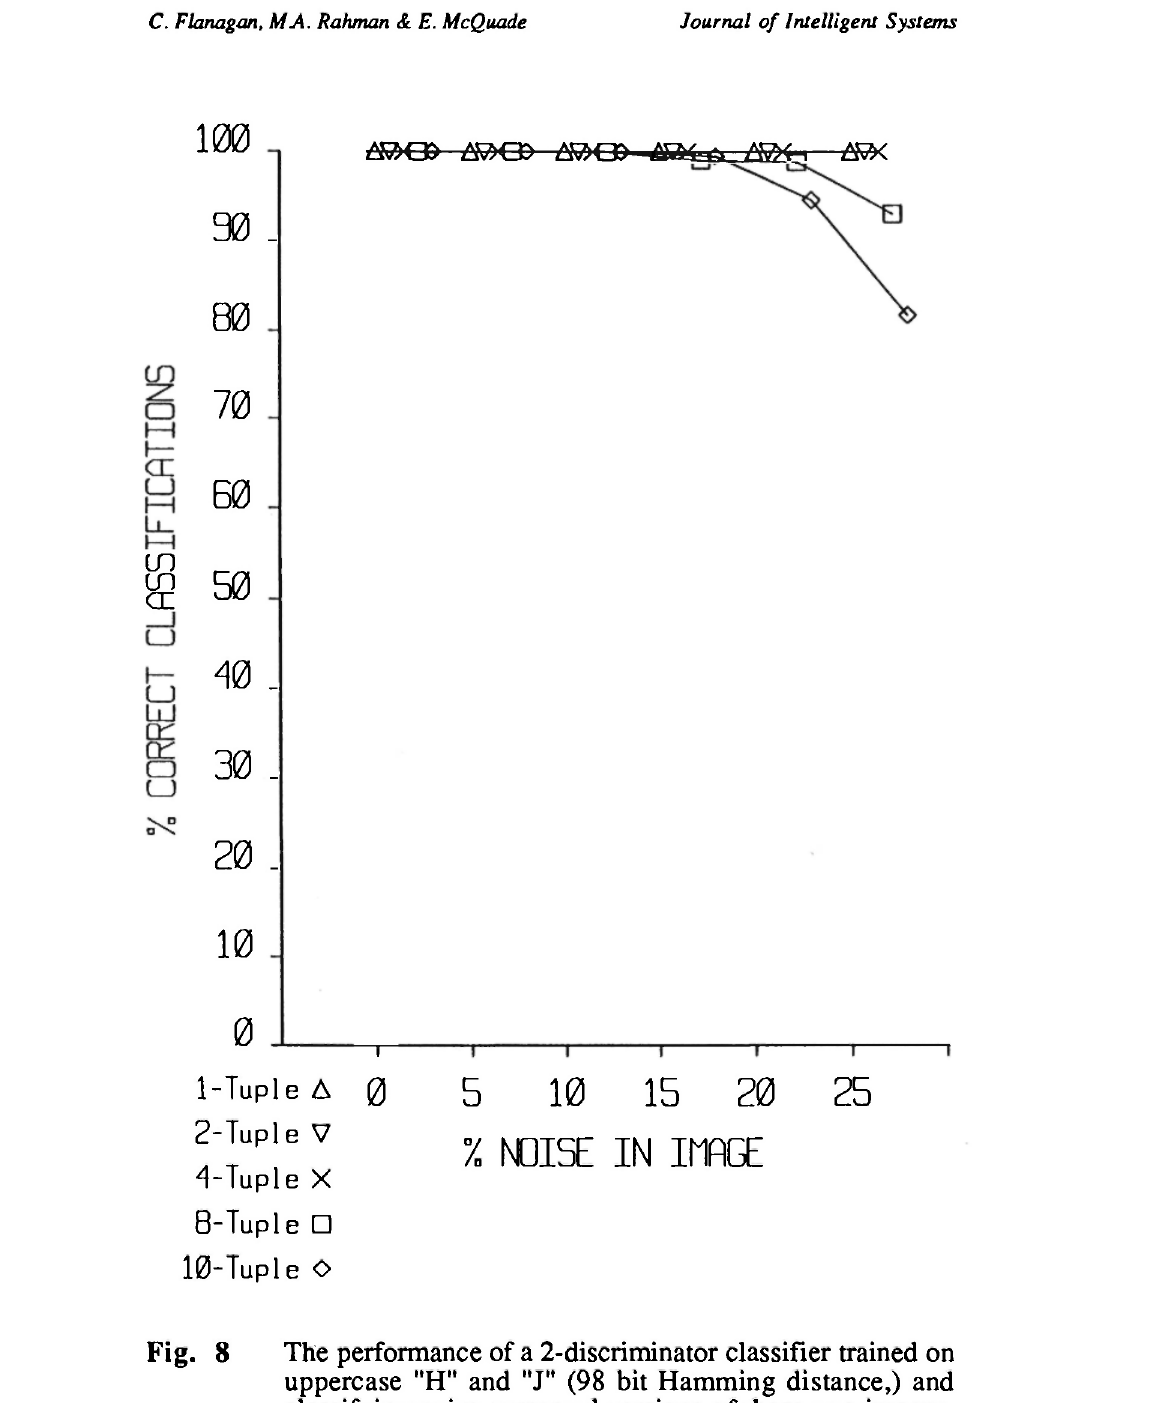
Fig. 8 The performance of a 2-discriminator classifier trained on uppercase "H" and "J" (98 bit Hamming distance,) and classifying noise-corrupted versions of these two